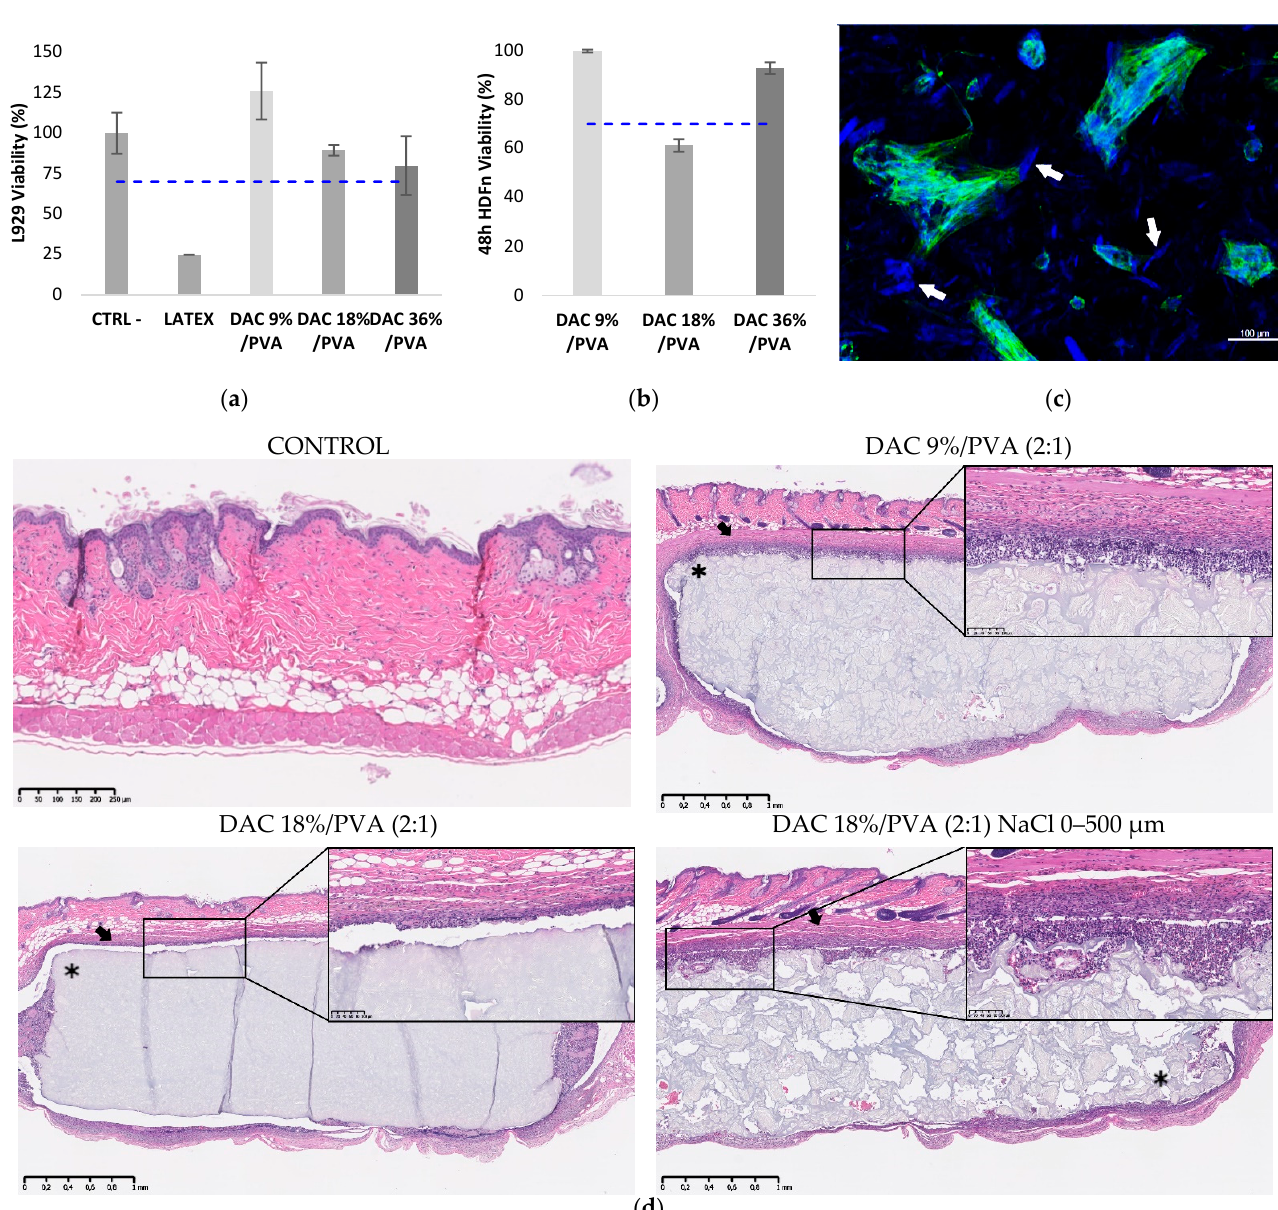
Figure 7. ( a ) DAC/PVA (2:1) NaCl hydrogels cytocompatibility test following the ISO10993 standard protocol (n = 3); ( b ) Neonatal human dermal fibroblast (HDFn) cultured on DAC/PVA (2:1) NaCl hydrogels viability assay at 48 h (n = 3); ( c ) Observation of adhered HDFn and spheroid-like structure on 9% DAC/PVA (2:1) material. DAPI: cell nucleus (blue); Phalloidin: cell cytoskeleton (green); White arrow: cellulose. ( d ) Examination of in vivo biocompatibility and biostability of nanoporous and macroporous cellulosic materials in a nude mouse model through histological study upon 1-month subcutaneous implantation (n = 3). *: cellulosic implant; arrow: fibrous capsule.